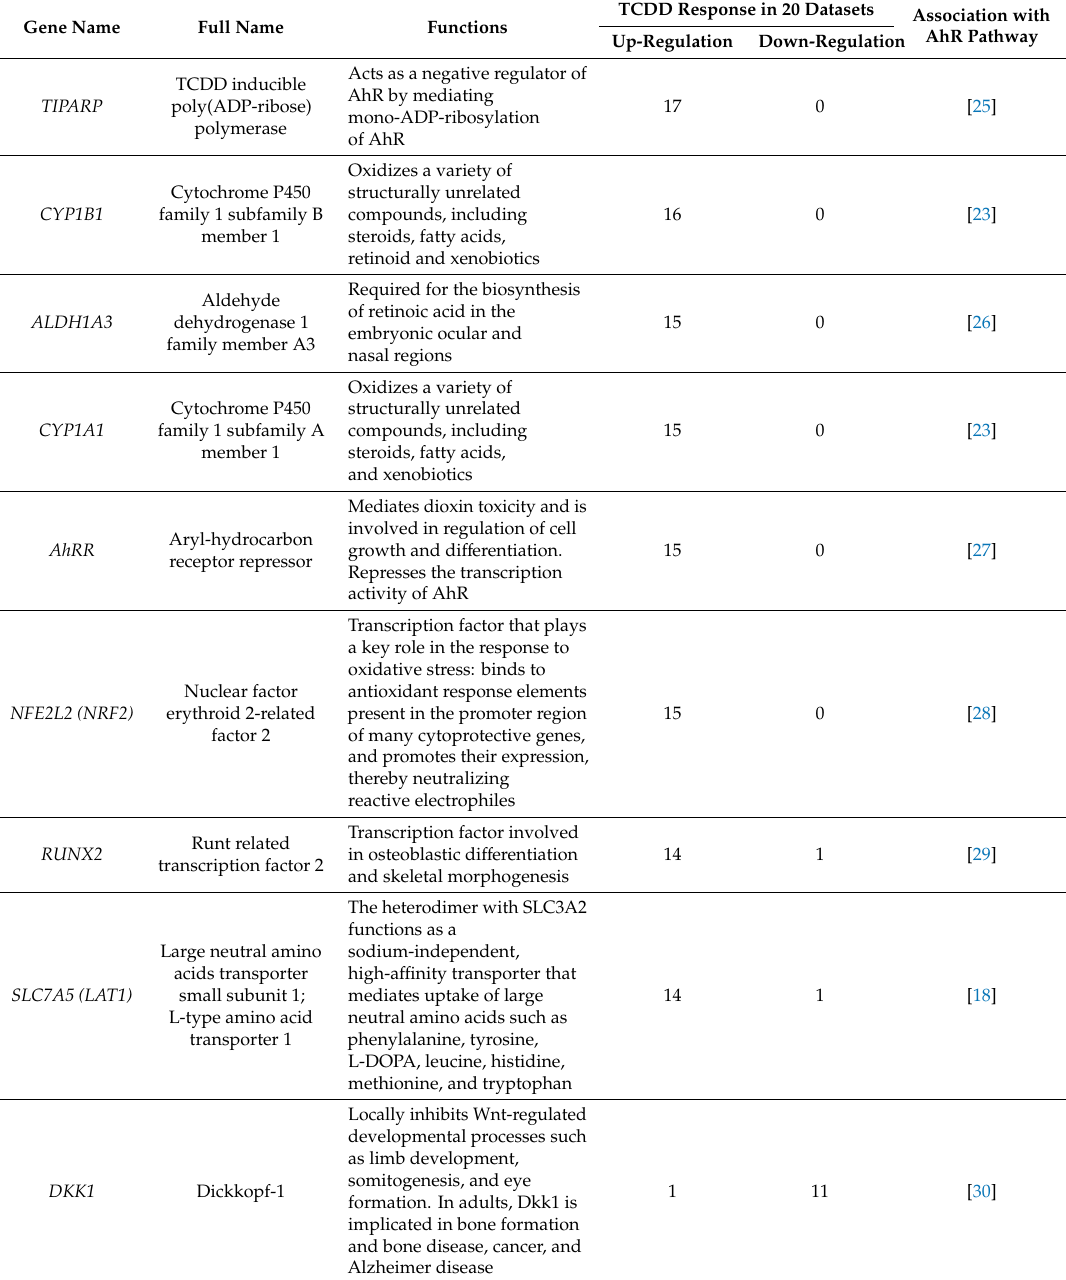
Table 2. The most robustly a ff ected genes in response to TCDD that are known to be associated with either the dioxin response or the AhR pathway. The gene function annotations were taken from the UniProtKB